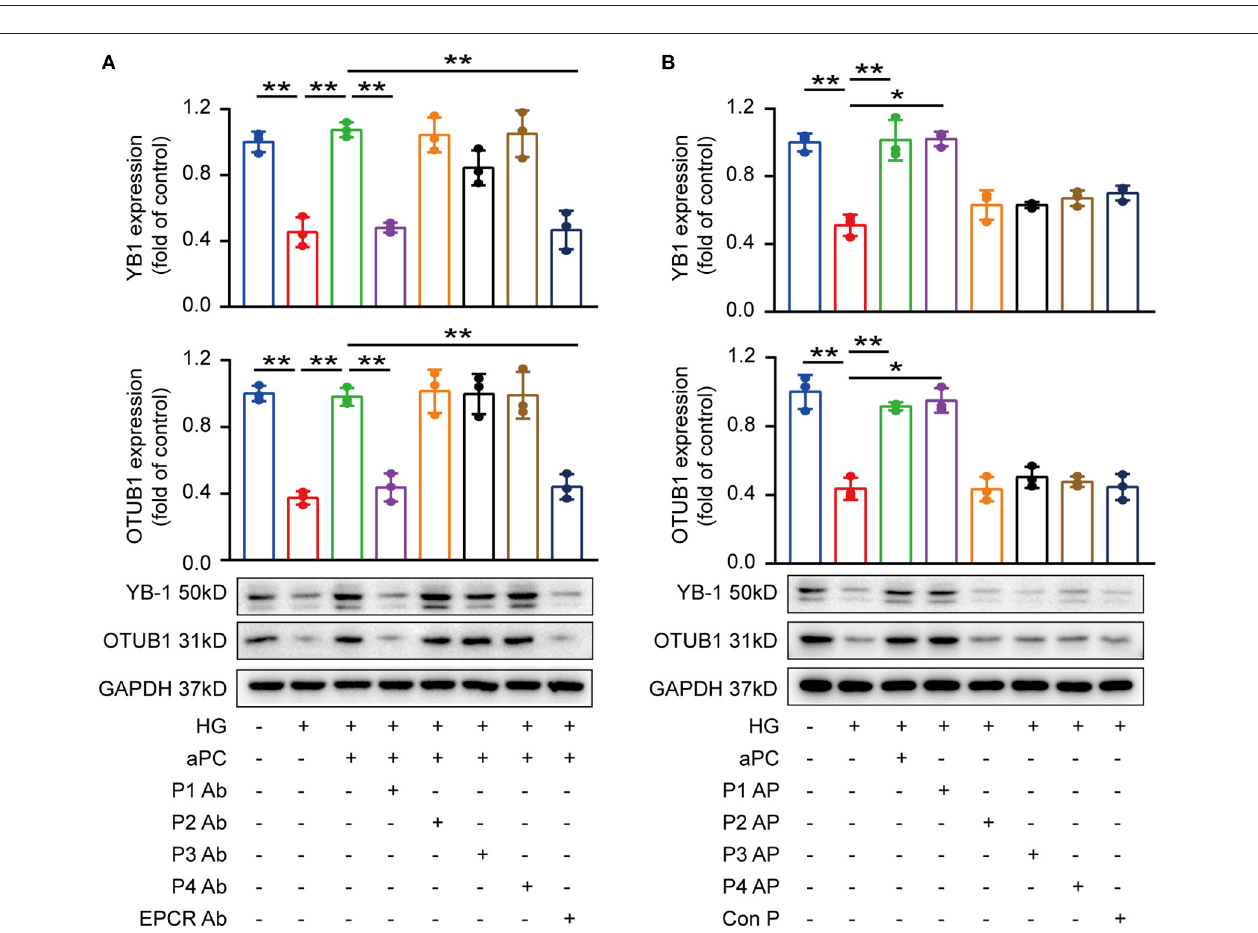
FIGURE 5 | aPC maintains YB-1 and OTUB1 expression via PAR1 and EPCR. (A) H9c2 cells were pre-treated with specific blocking antibodies (20 µ g/ml, 1h) then aPC (20nM, 30min), and thereafter HG (25mM, 6h). Western blots showed that PAR1 and EPCR blocking antibodies abolished the protective effect of aPC on maintaining the expression of YB-1 and OTUB1. (B) H9c2 cells were pre-treated with PAR agonists or control peptide (10 µ M, 1h). PAR1 agonist could maintain YB-1 and OTUB1 expression. Data were represented as fold of control, mean ± SD. n = 3 for all groups. HG, 25 mmol/L D ( + ) glucose; aPC, activated protein C; P1-4, Protease activated receptor 1–4; EPCR, Endothelial protein C receptor; Ab, antibody; AP, agonist peptide. * P < 0.05, ** P < 0.01. Student’s t- test, Bonferroni comparison test. All the blots were performed at least in